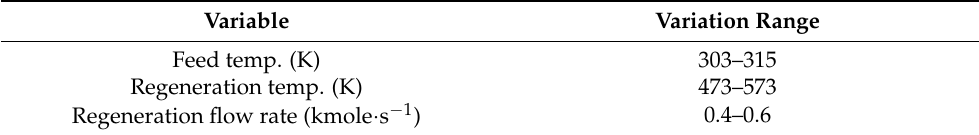
Table 6. Considered intervals for